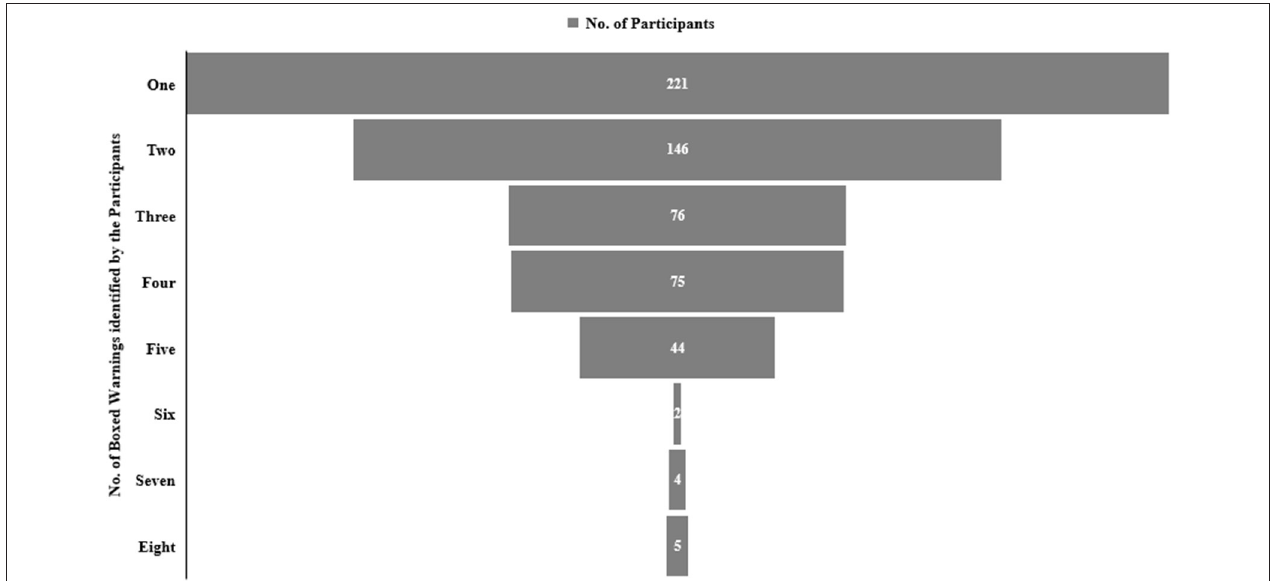
Frontiers in Medicine |